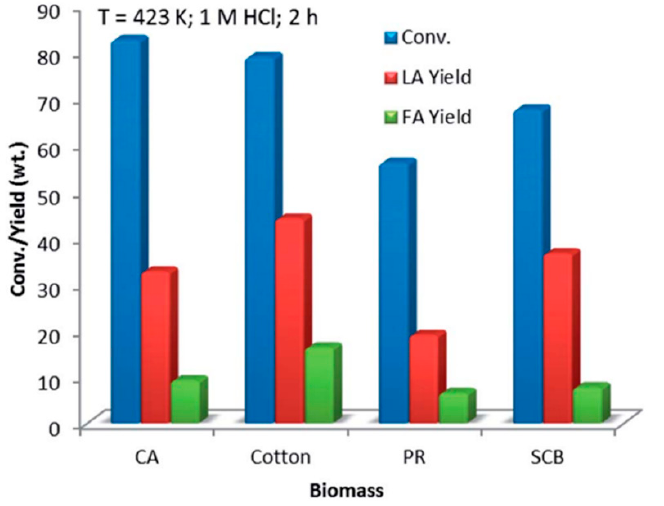
Figure 5. Hydrothermal conversion of agricultural wastes, namely, Cicer arietinum (CA), cotton, Pinus radiata cones (PR) and sugar cane bagasse, to levulinic acid. Adapted with permission from RSC [70].